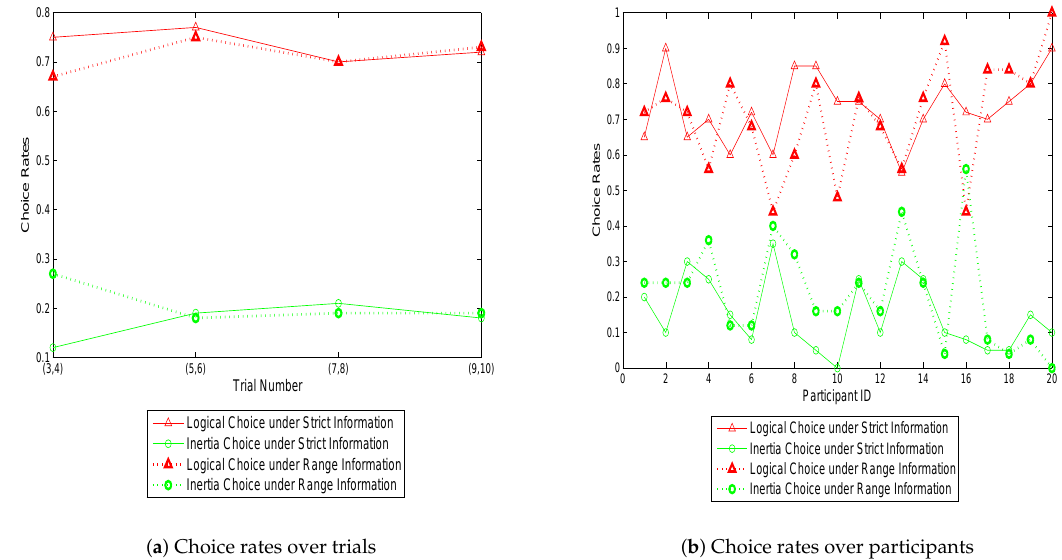
Figure 5. Choice rates with strict information vs. with range information.